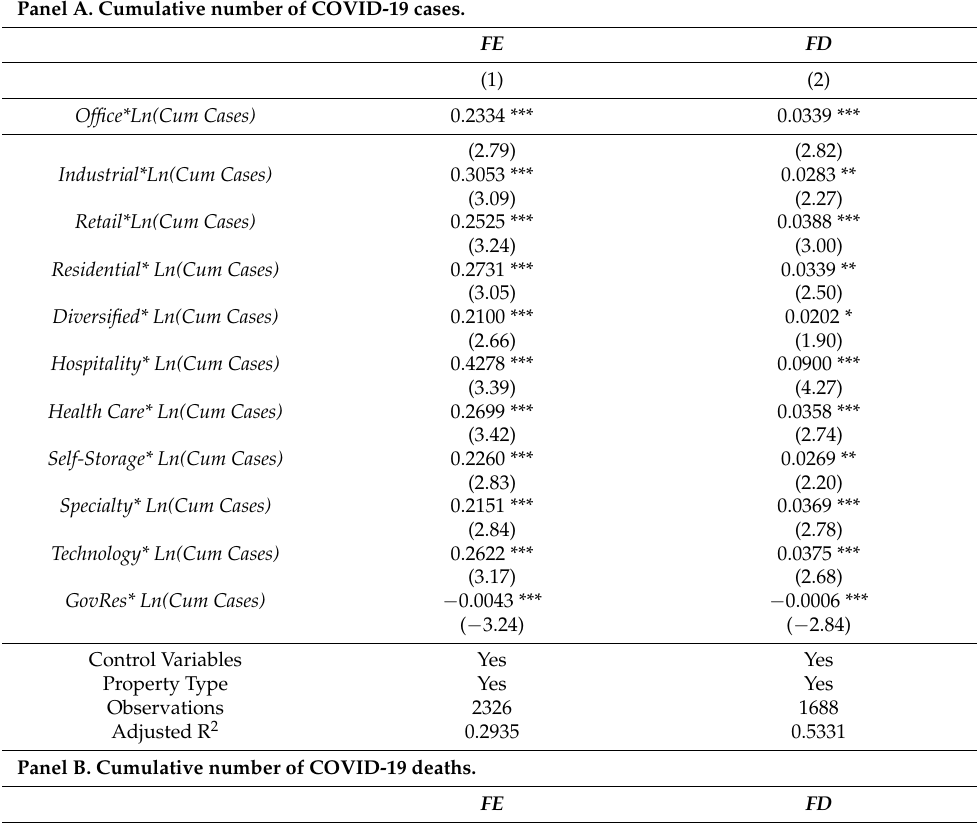
Table 5. The Differential Effects of the COVID-19 Pandemic across Property Types. Panel A. Cumulative number of COVID-19 cases.